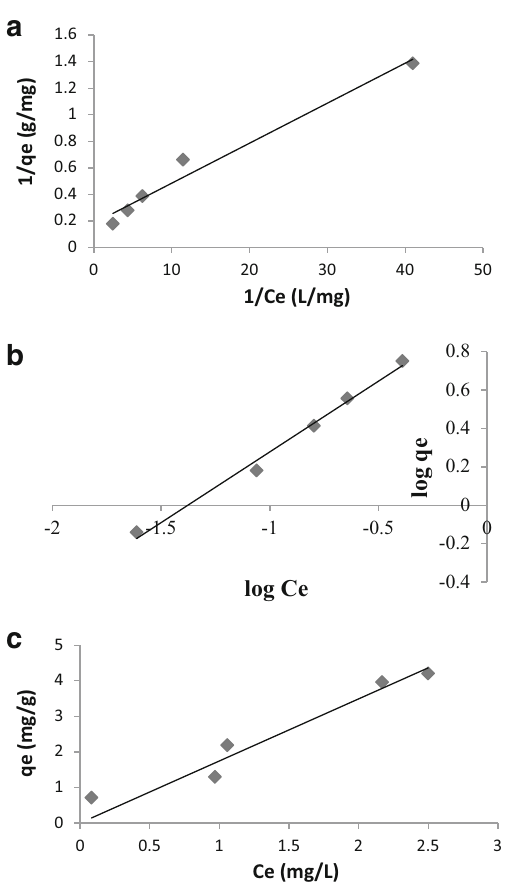
Fig. 8 a Langmuir isotherm model. b Freundlich isotherm model. c Linear isotherm model